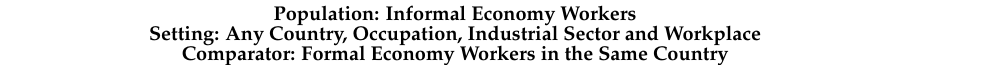
Table 4. Summary of findings: use of health services and health outcomes among informal economy workers, compared with formal economy